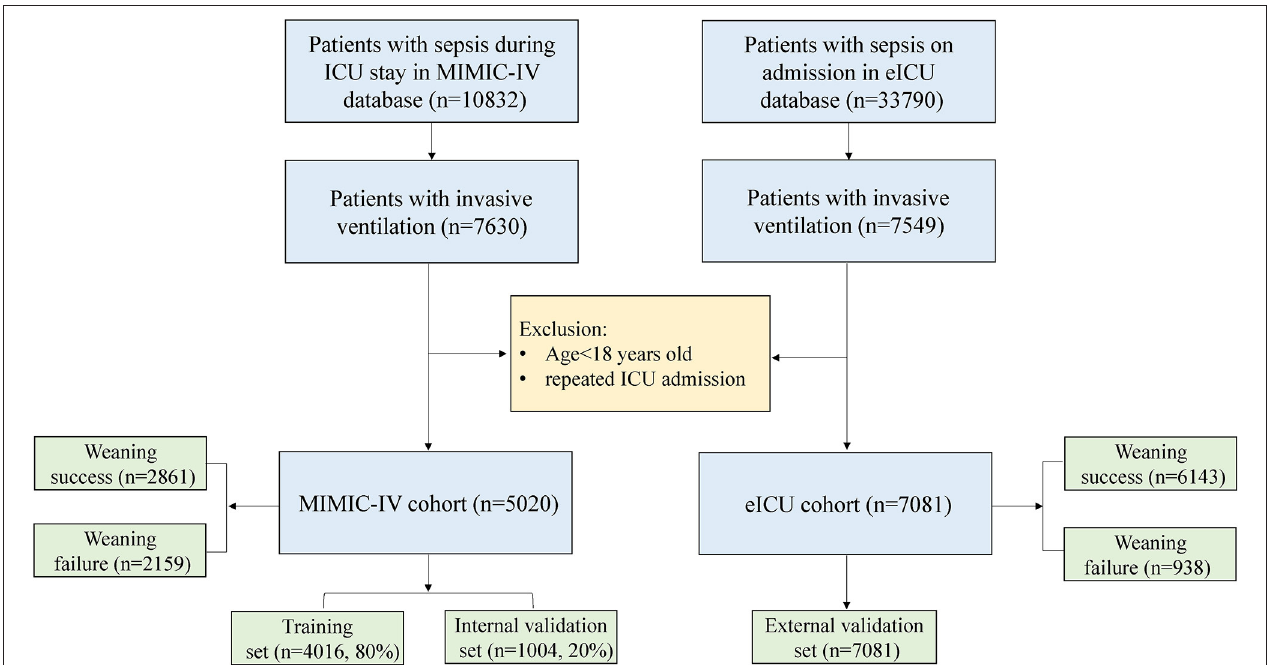
FIGURE 1 | The flow chart of data extraction. eICU-CRD, eICU-CRD Collaborative Research Database. MIMIC-IV, Medical Information Mart for Intensive Care-IV; ICU, intensive care unit.